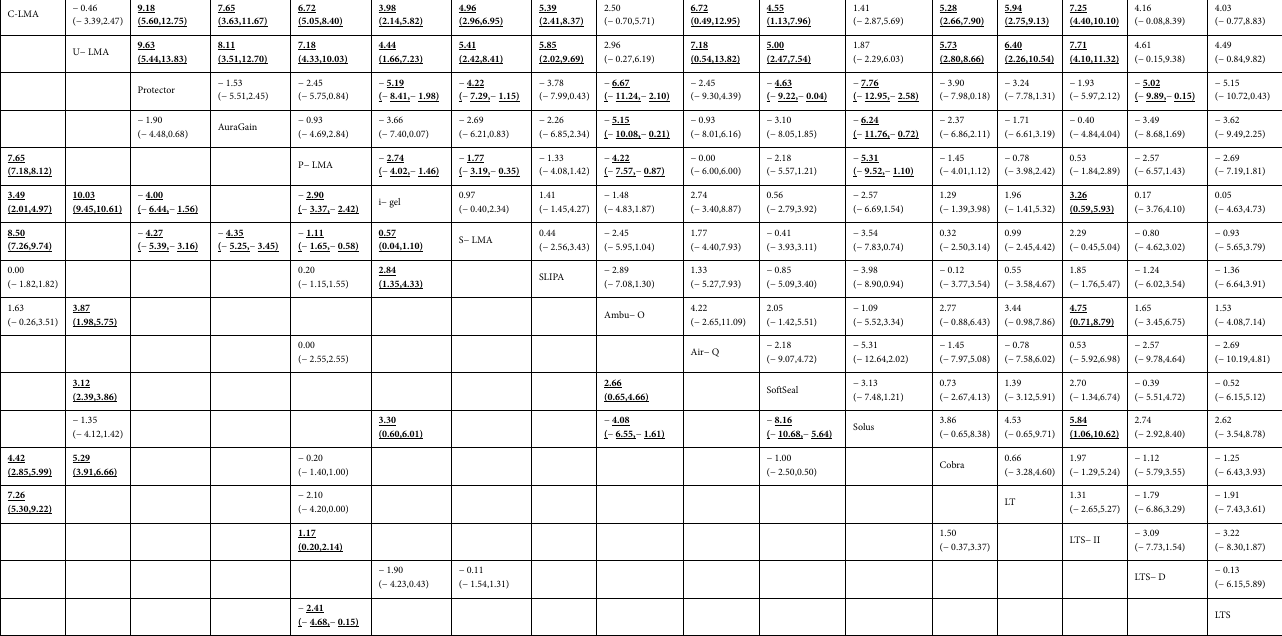
Table 2. Results for oropharyngeal leak pressure from network meta-analysis. The device in column one is the index device and that in row one is the comparator. The upper triangle is the results of the network meta-analysis, and the lower triangle is the results of the traditional pairwise meta-analysis. The device in the row one minus the device in column one equals the mean difference, which unit is cmH 2 O. Bold and underscored means significance. The significance means the confidence interval not containing the “0”. C-LMA, LMA Classic; U-LMA, Unique LMA; Protector, LMA Protector Airway; AuraGain, Ambu AuraGain Disposable Laryngeal Mask; P-LMA, Proseal LMA; I-gel, I-gel supraglottic airway; S-LMA, Supreme LMA; SLIPA, Streamlined Liner of the Pharynx Airway; Ambu-O, Ambu AuraOnce; Air-Q, Air-Q Masked Laryngeal Airway.; SoftSeal, The Portex Soft Seal Laryngeal Mask; Solus, Solus Standard Laryngeal Mask Airway; Cobra, Cobra Perilaryngeal Airway; LT, Laryngeal Tube; LTSII, Laryngeal Tube Suction II; LTS-D, Laryngeal Tube Disposable; LTS, Laryngeal Tube